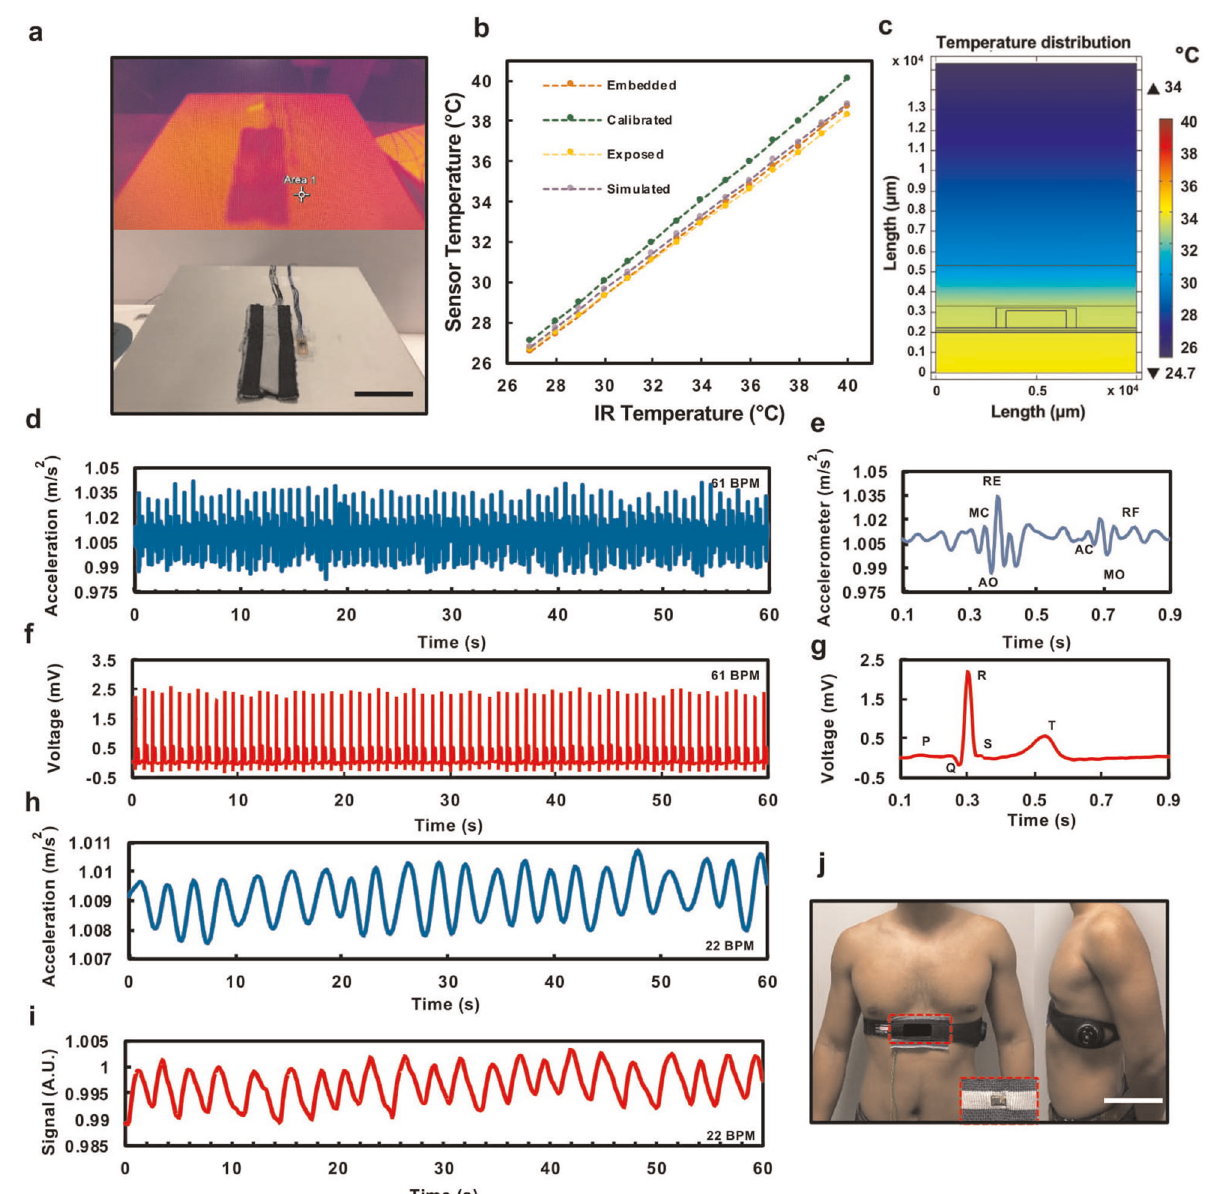
Fig. 2 Thermal characterization of temperature sensor-embedded fabric. The photography of ( a ) the hot-plate setup and thermal image between bare temperature sensor and the one integrated in a fabric (scale bar: 3 cm). b Characterization, simulation, and calibration results of the IR camera thermal test. c FEM thermal distribution for a source temperature of 34 °C. Simultaneous measurement of accelerometer SCG with a commercial ECG. d Mechano-acoustic response of accelerometer embedded in a fabric for 1 min. A.U.: arbitrary unit. e Magni fi ed view of heart acoustic signals in ( d ), MC, mitral valve closure; AO, aortic valve opening; RE, rapid ventricular ejection; AC, aortic valve closure; MO, mitral valve opening; RF, rapid ventricular fi lling. f A commercial ECG response under 1 min. g Magni fi ed view of the ECG response in ( f ). h Commercial accelerometer and ( i ) Zephyr Biopatch respiratory waveform. A.U.: arbitrary unit, and ( j ) Zephyr Biopatch and fabric accelerometer sensor placement (scale bar: 10 simulated. The simulated results matched the experimental results with a tolerance of 0.2308 ± 0.0488 °C. Figure 2c shows a sample of the simulated thermal distribution across the 2-D model when the hot-plate temperature is 34 °C, while Supplementary Fig. 3b – g shows the distribution when the hot-plate temperature is ranged from 30 to 40 °C. Seismocardiography (SCG) records the subtle motions around the body due to the atrial muscle contractions and blood ejection